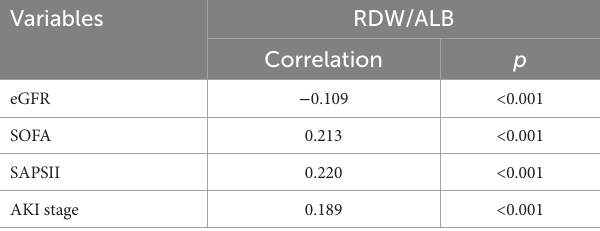
TABLE 2 The correlation of indexes of the severity of patients’ conditions and kidney dysfunction with the RDW/ALB